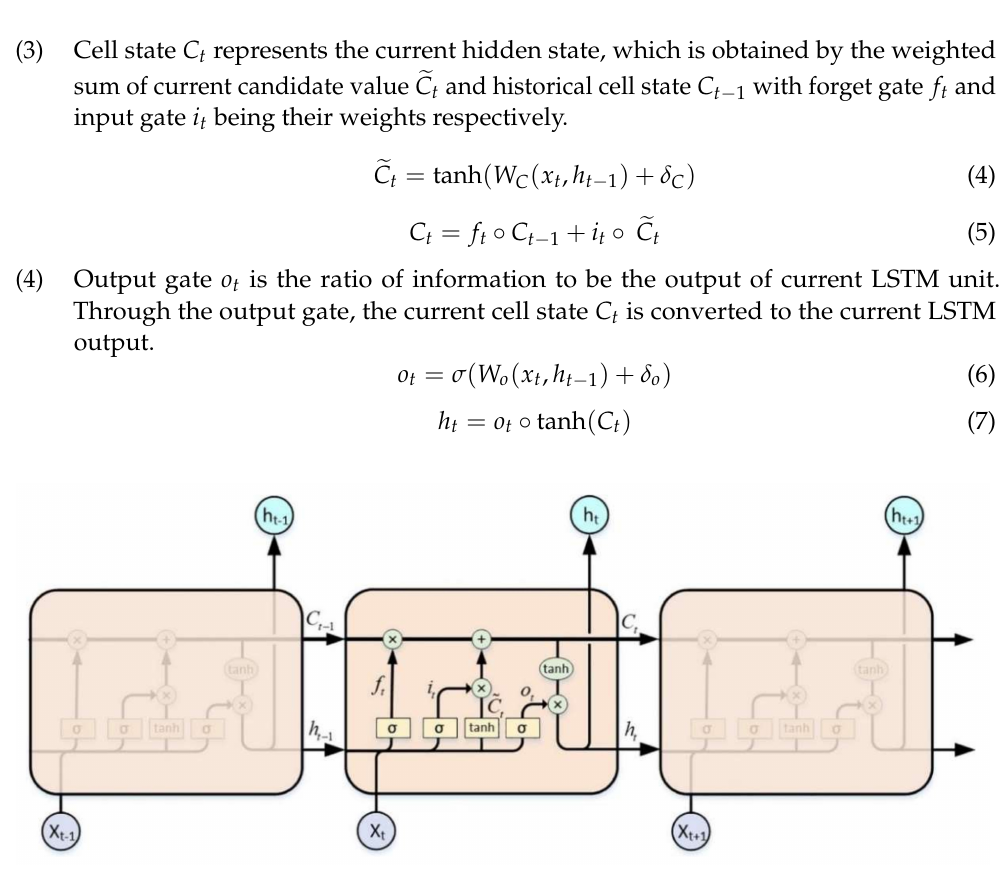
Figure 2. Structure of LSTM network